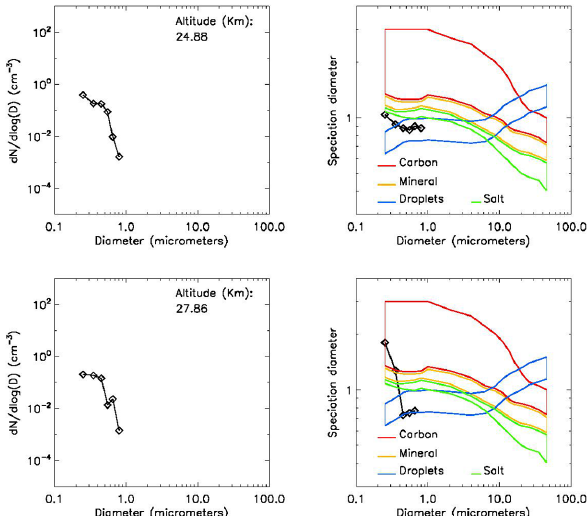
Figure 18. Examples of size distributions and typology at two alti- tudes for the 12 August 2015 LOAC flight from Aire-sur-l’Adour (France); the uncertainties for concentrations are the same as in Fig. 17; the sizes of the dots represent the error bars for the typol- ogy. At an altitude of ∼ 25km, the typology indicates mainly liquid particles; at an altitude of ∼ 28km, the typology also indicates the presence of carbonaceous particles at the smallest